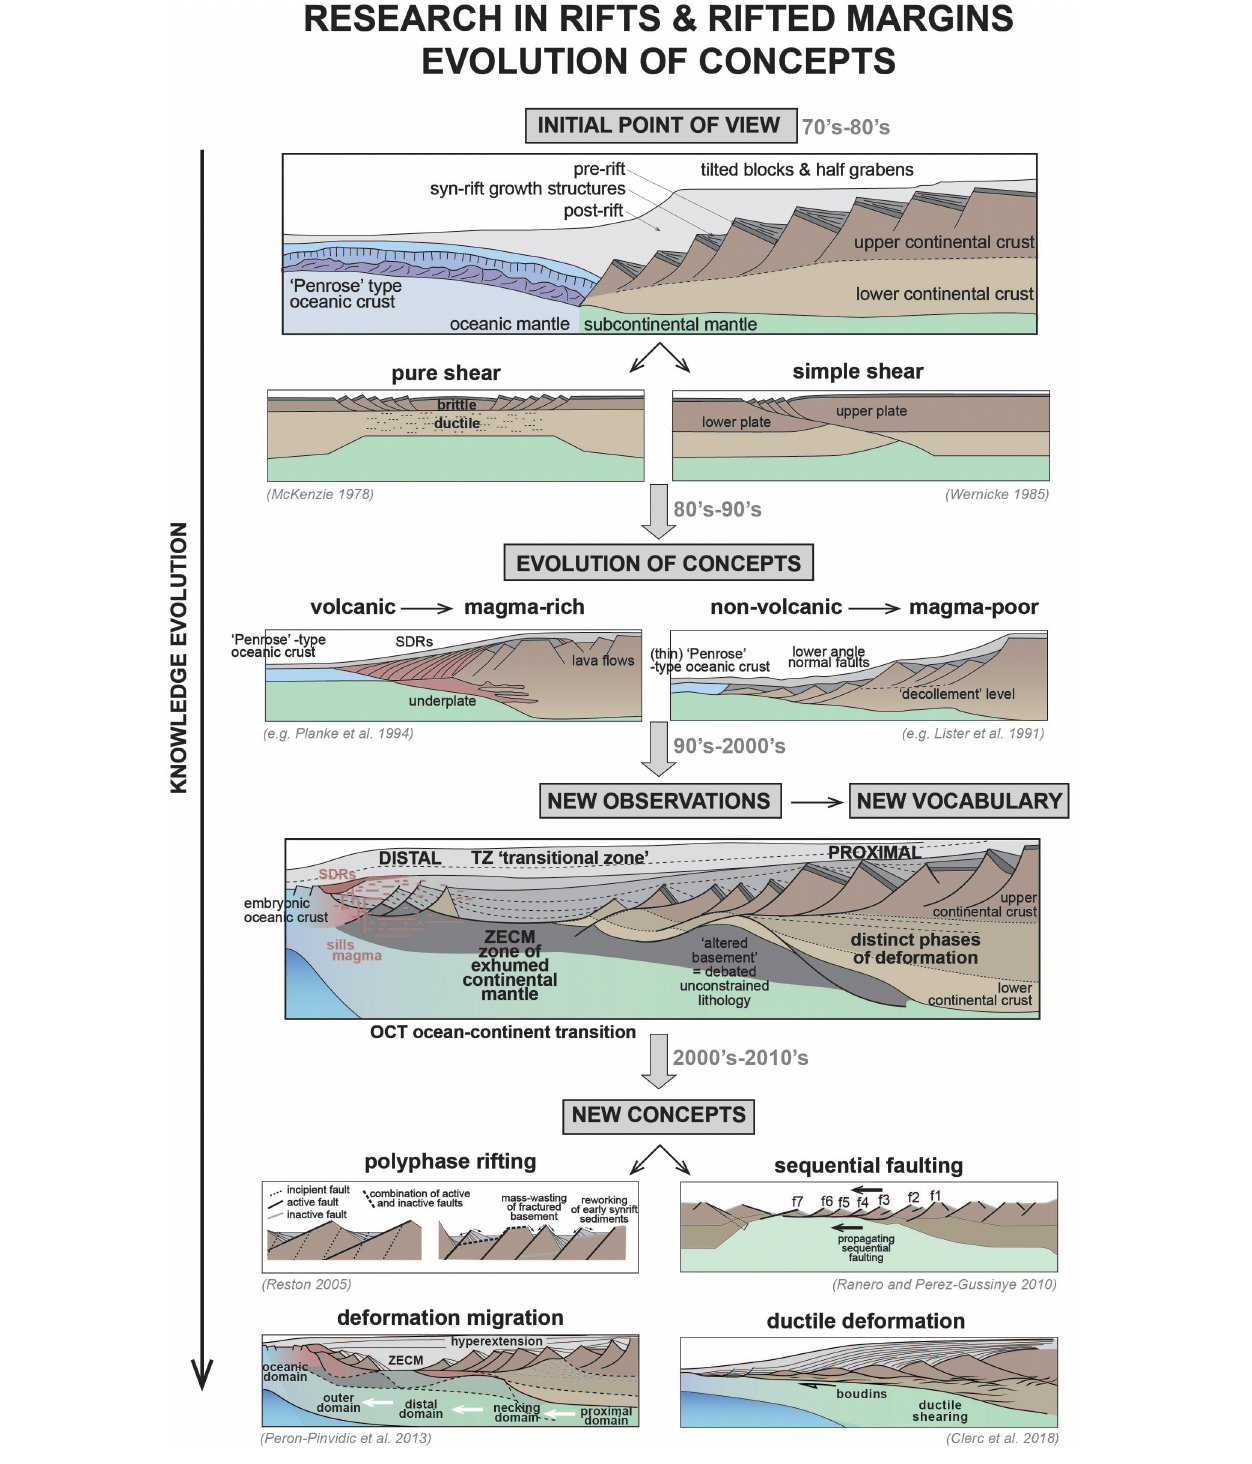
FIGURE 1 | Schematic representation of the significant progress of knowledge operated by the rifted margin community these last decades, from top (initial point of view from the 70’s) to bottom (new concepts with illustration of recent models) The initial models attempting to represent rifted margins envisaged a continental crust gradually thinned oceanward and juxtaposed to a normal three-layers -type oceanic crust. Thanks to improvements in offshore imaging and modeling techniques, rifted margins are not examined within an end-member classification (volcanic/non-volcanic) anymore, but in light of a gradual change in processes (new observations – new